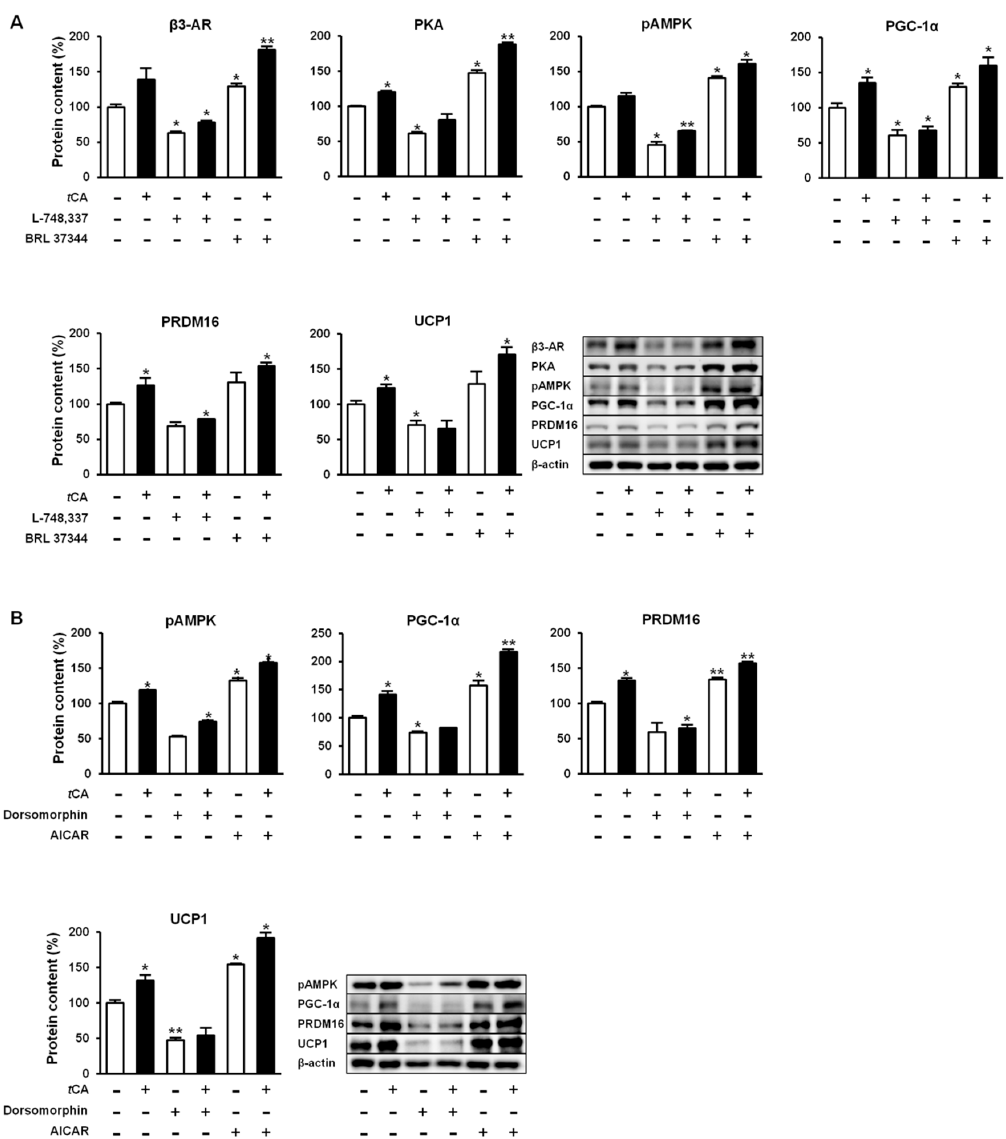
Figure 5. Trans -cinnamic acid ( t CA) induces browning via β 3-AR as well as AMPK pathway in 3T3-L1 adipocytes. t CA activates β 3-AR and promotes browning by elevating expression of browning markers PGC-1 α , PRDM16, and UCP1 ( A ) as well as AMPK-mediated activation of β 3-AR to pAMPK, resulting in higher expression levels of browning markers ( B ) in comparison to the effect of β 3-AR. Data are presented as the mean ± SD, and differences between groups were determined using the Statistical Package of Social Science (SPSS, version 17.0; SPSS Inc., Chicago, IL, USA) program, followed by Tukey’s post-hoc tests. Statistical significance between control and t CA-treated 3T3-L1 cells are shown as * p < 0.05 or ** p < 0.01.